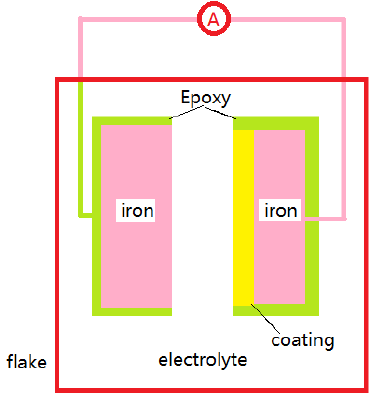
Figure 5. The schematic of cathodic protection experiments in seawater for Q235 steel and AlZn composites coating system.